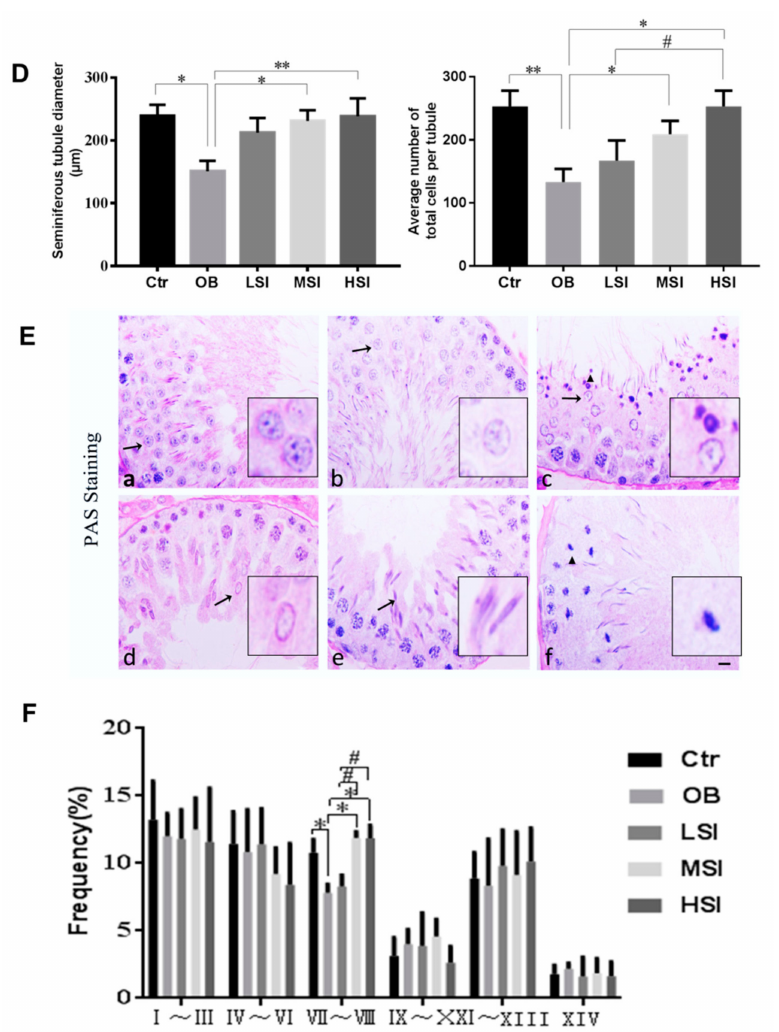
Figure 1. Soy isoflavones (SIF) promote spermatogenesis in diet-induced obese (DIO) male rats. ( A ) E ff ects of SIF on the testis weight and the testicular coe ffi cient of adult male obese rats. ( B ) E ff ects of SIF on the sperm parameters of adult male obese rats. ( C ) Histological morphology of testis stained with HE from the five groups; pathological changes of seminiferous tubule (black arrow); magnification: × 200; scale bar: 100 µ m. Magnification: × 400; scale bar: 50 µ m. ( D ) Quantifcation shows the diameter of seminiferous tubules and mean number of the total cells per tubule of the five groups. ( E ) The testicles of rats staining with PAS-H staining. (a) I–III stages. Acrosomal vacuole (black arrow); (b) IV–VI stages. Acrosome (black arrow); (c) VII-VIII stages. Acrosome (black arrow) and residual body (black triangle); (d) IX-X stages. The circular sperm nuclei move from the center to the cell near the cell membrane side (black arrow); (e) XI-XIII stages. Sperm cells are further deformed, nuclear condensation(black arrow); (f) XIV stages. Meiotic phase (black triangle). Scale bar: 10 µ m; Magnification: × 1000. ( F ) Quantification shows the seminiferous epithelial cycle count. Each bar denotes mean ± SD of eight rats. * p < 0.05, ** p < 0.01 vs. OB group; # p < 0.05, ## p < 0.01 vs. LSI; ∆ p < 0.05, ∆∆ p < 0.05vs. MSI, one-way ANOVA analysis and Least—Significant Di ff erence (LSD)